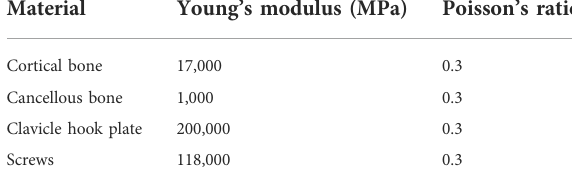
TABLE 1 Material properties of this study.